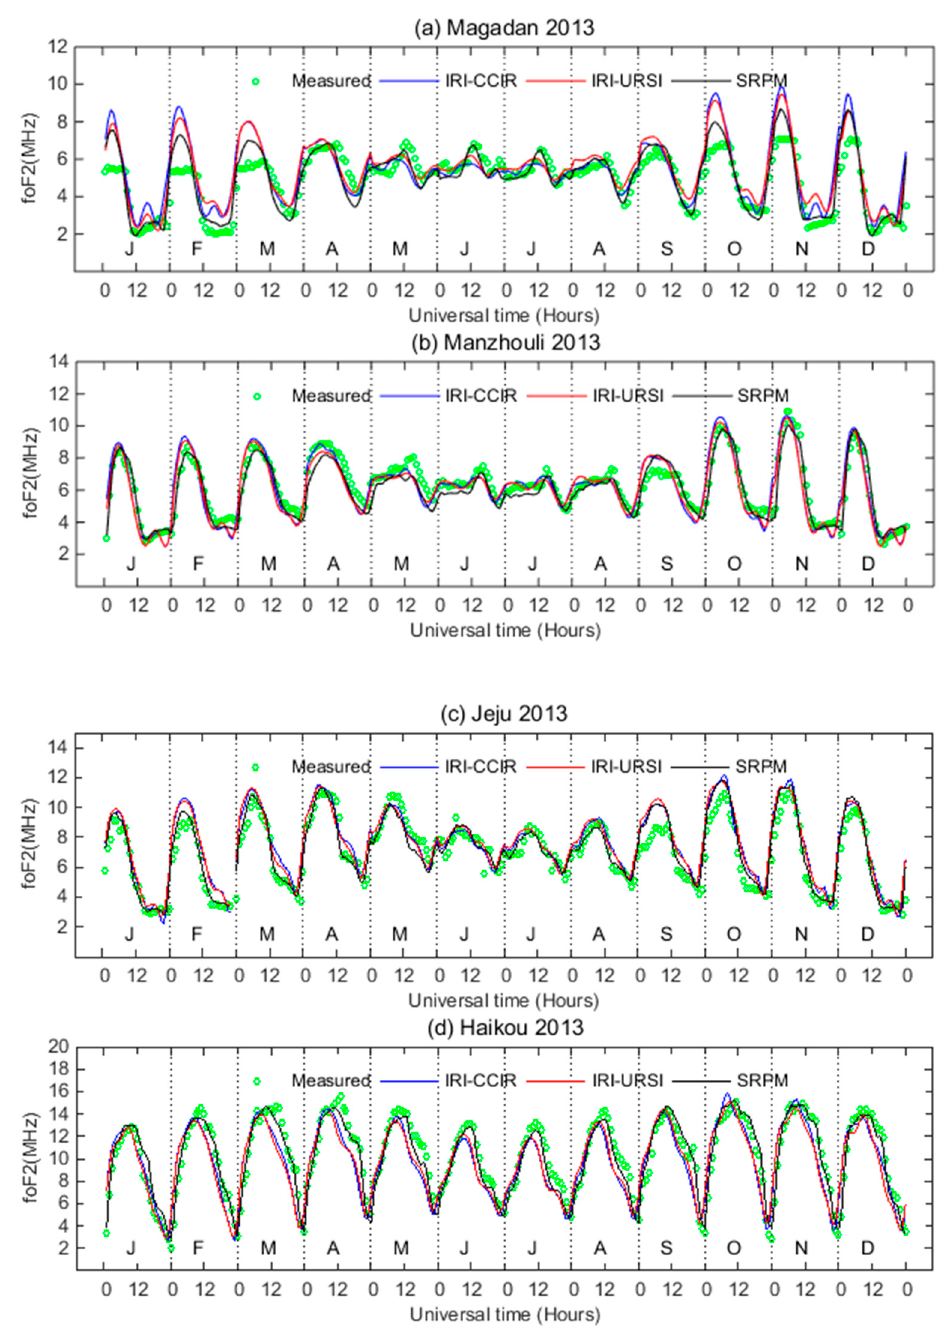
Figure 10. Sample plots of different model predicted value and measured value of f o F 2 for the year 2013 (high solar activity year). From top to bottom panels, stations are ordered from high, middle and low latitude, which are Magadan, Manzhouli, Jeju and Haikou stations. ( a ) Magadan station; ( b ) Manzhouli station; ( c ) Jeju station; ( d ) Haikou station.